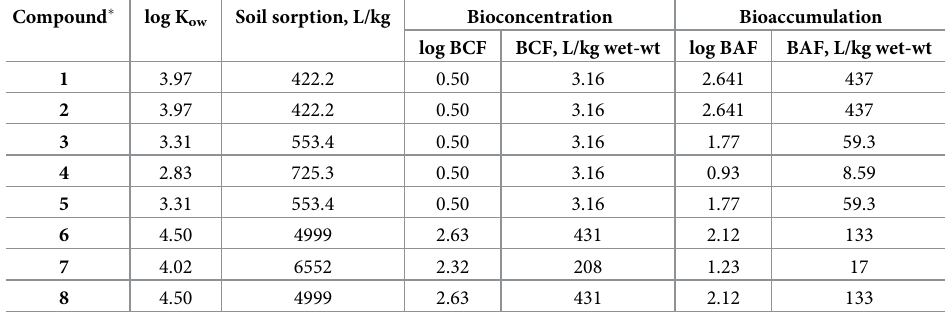
Table 5. Soil sorption, bioconcentration and bioaccumulation of IBP and its transformation products calculated using EPI Suite. Compound � Soil sorption,